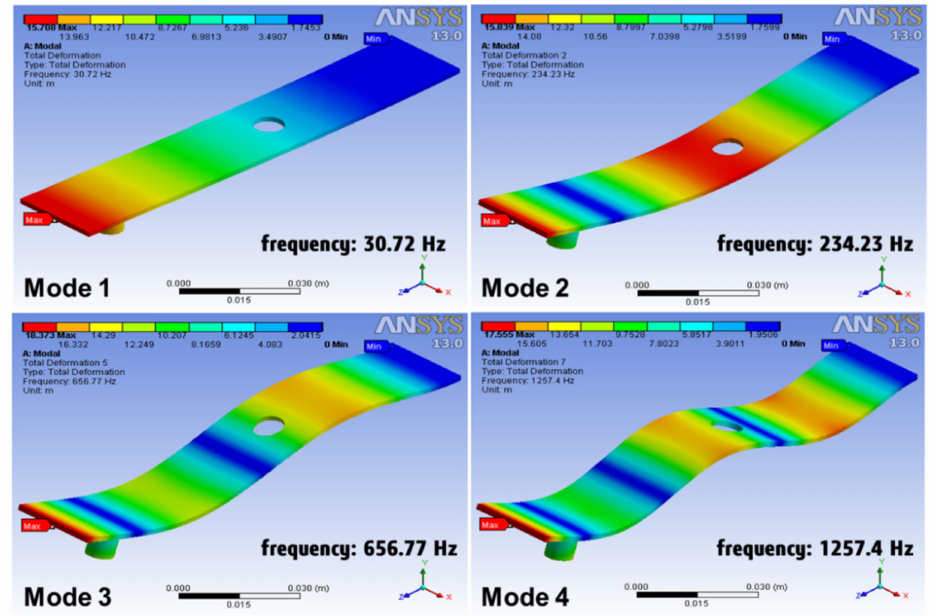
Figure 8. Mode shapes for a single specimen (W = 24 mm, D = 8 mm) in Group 3.